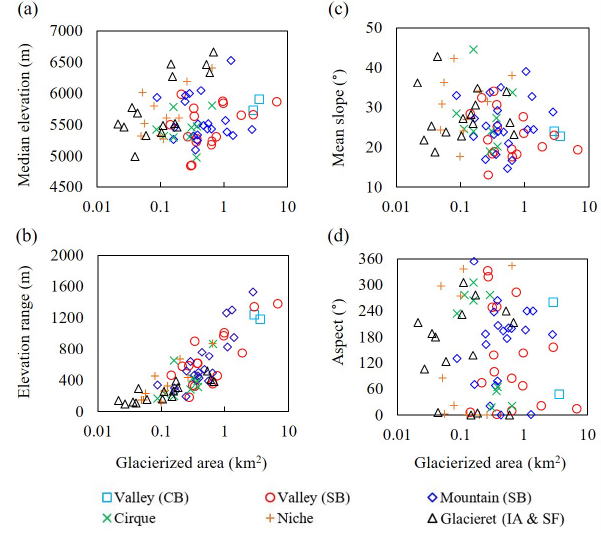
Figure 7. Scatter plots showing relationships between different morphological types of glacierized area (km 2 ) and (a) median el- evation (m), (b) mean slope ( ◦ ), (c) elevation range (m), and (d) as- pect ( ◦ ). Glacier characteristics are derived from the Sentinel-2A MSI and SRTM